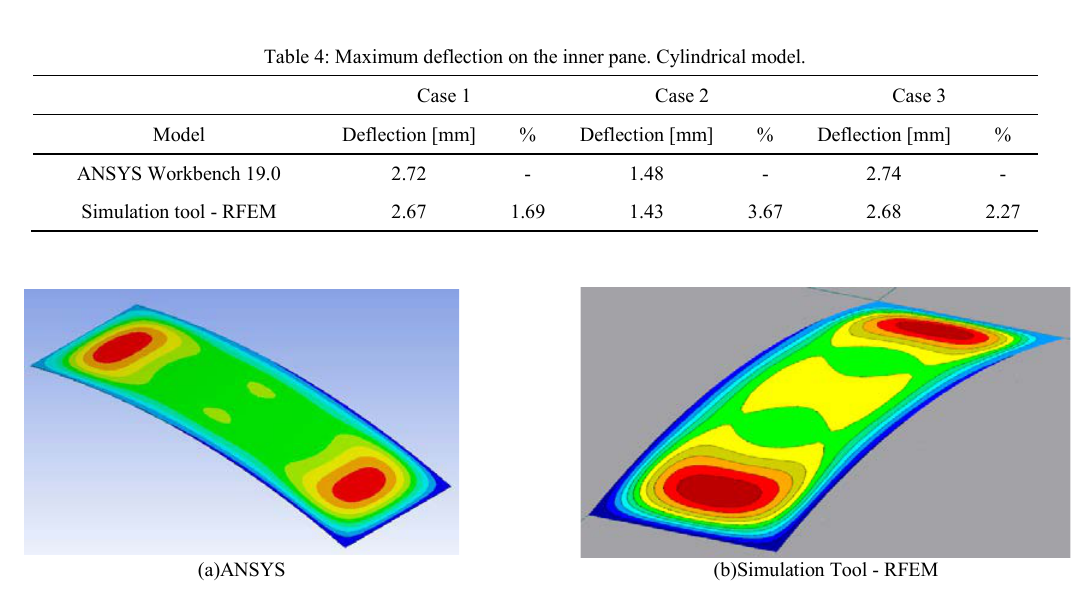
Fig. 2 Deflection of the inner panel of the cylindrical model. Case